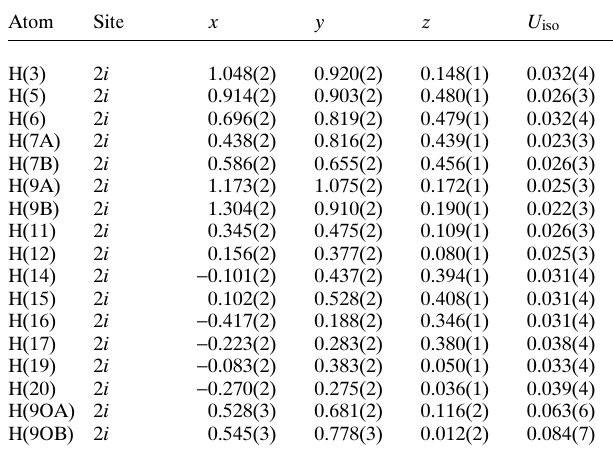
Table 1. Data collection and